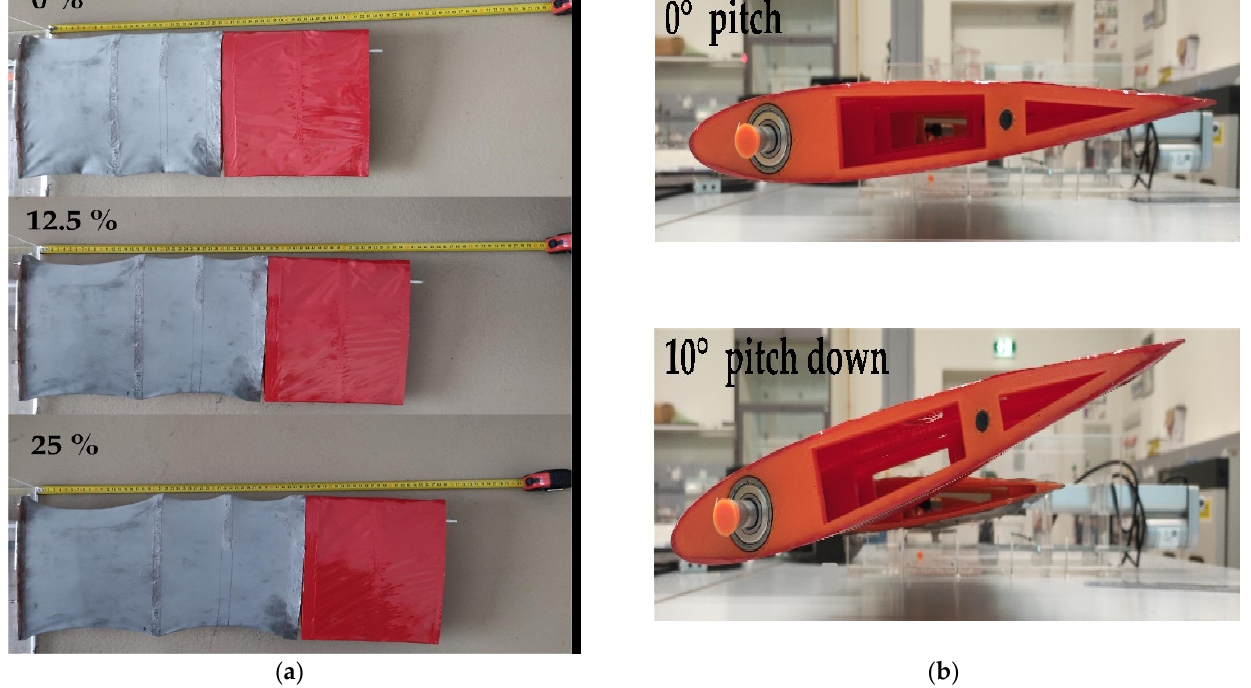
Figure 21. ASAPP wing pre- and post-morphing: ( a ) Before and after span extension. ( b ) Before and after pitching.